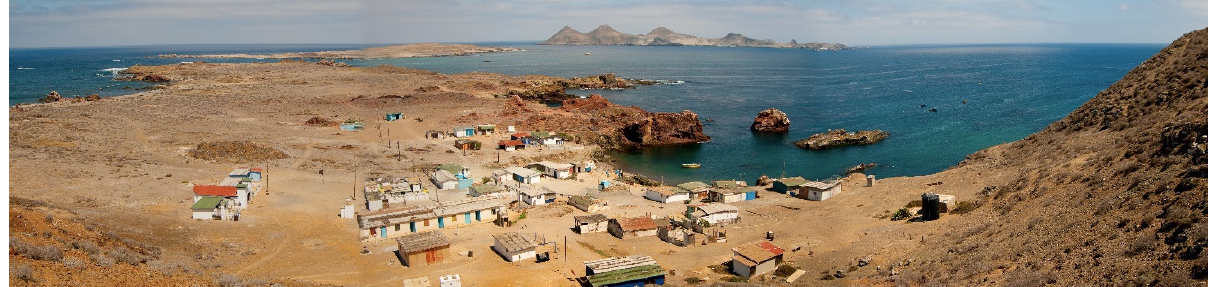
Figure 2. Panoramic view of Pescadores Nacionales de Abulón fishing camp on San Benito Oeste Island. This was the base of operations for the mouse eradication project. Photo: © GECI/J.A. Soriano.